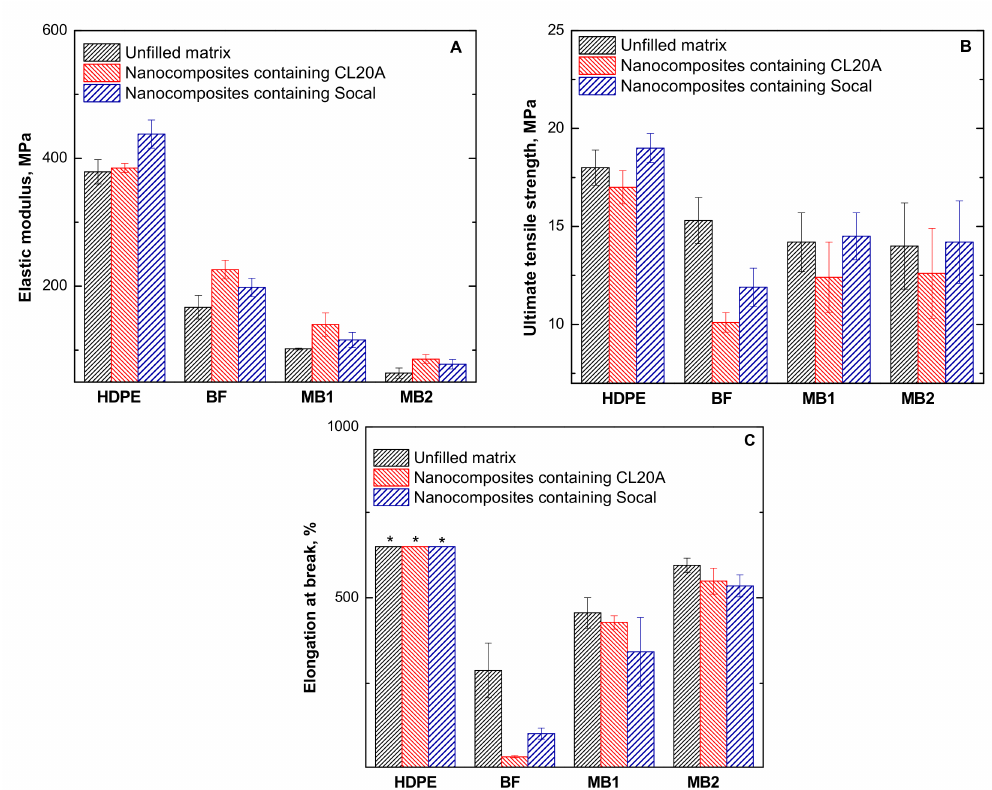
Figure 5. ( A ) Elastic modulus, ( B ) ultimate tensile strength, and ( C ) elongation at break for all investigated materials. Asterisk (*) indicates values exceeding the maximum measurable value, i.e.,